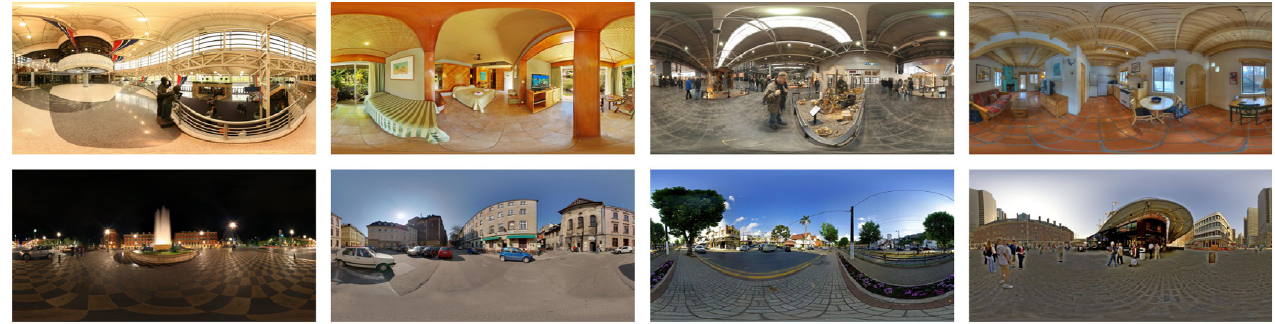
Fig 1. Examples of panoramic scenes. Examples of the panoramic scenes are shown that were used in the present experiment. Indoor scenes are shown in the top row, outdoor scenes in the bottom row.